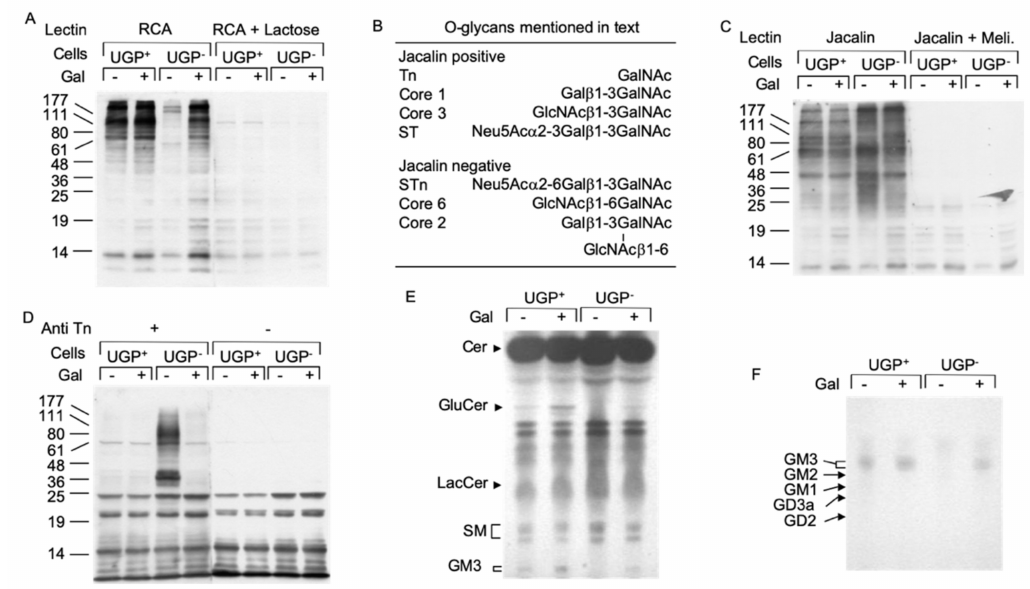
Figure 4. Deficits in protein O -glycosylation and glycosphingolipid biosynthesis in UGP − cells. ( A ). UGP + and UGP − cells were incubated in media containing either 1 mM Glc or 1 mM Glc + 5 mM Gal for 24 h. Cell extracts were analyzed by SDS PAGE and after transfer of proteins onto nitrocellulose membranes, glycoproteins bearing terminal non-reducing galactose residues were probed using biotinylated Ricin communis agglutinin I (RCA). To control for the specificity of lectin binding, a duplicate membrane was incubated with the lectin in the presence of 500 mM lactose. Bound lectin was detected using avidin peroxidase / ECL reagent. The migration positions of standard molecular weight (numbers in Kd) markers are indicated to the left of the blot. ( B ). As reported [12], Jacalin